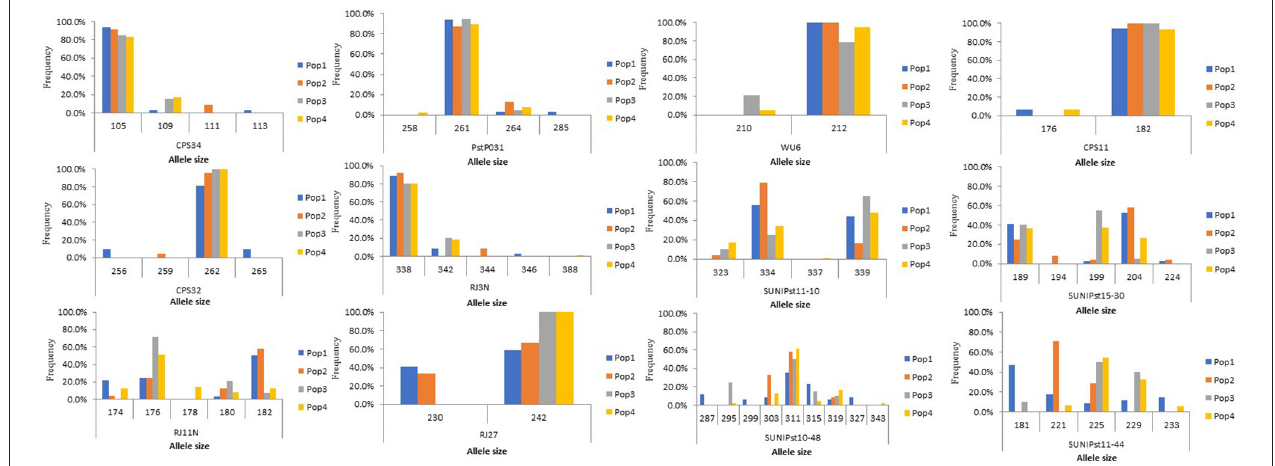
FIGURE 4 | Allele frequency for markers of CPS34, Pst P031, WU6, CPS11, CPS32, RJ3N, SUNI Pst 11-10, SUNI Pst 15-30, RJ11N, RJ27, SUNI Pst 10-48, SUNI Pst 11-44 in Puccinia striiformis f. sp. tritici populations from barberry bushes (Pop1-Pop2) and wheat plants close to the barberry bushes (Pop3-Pop4).